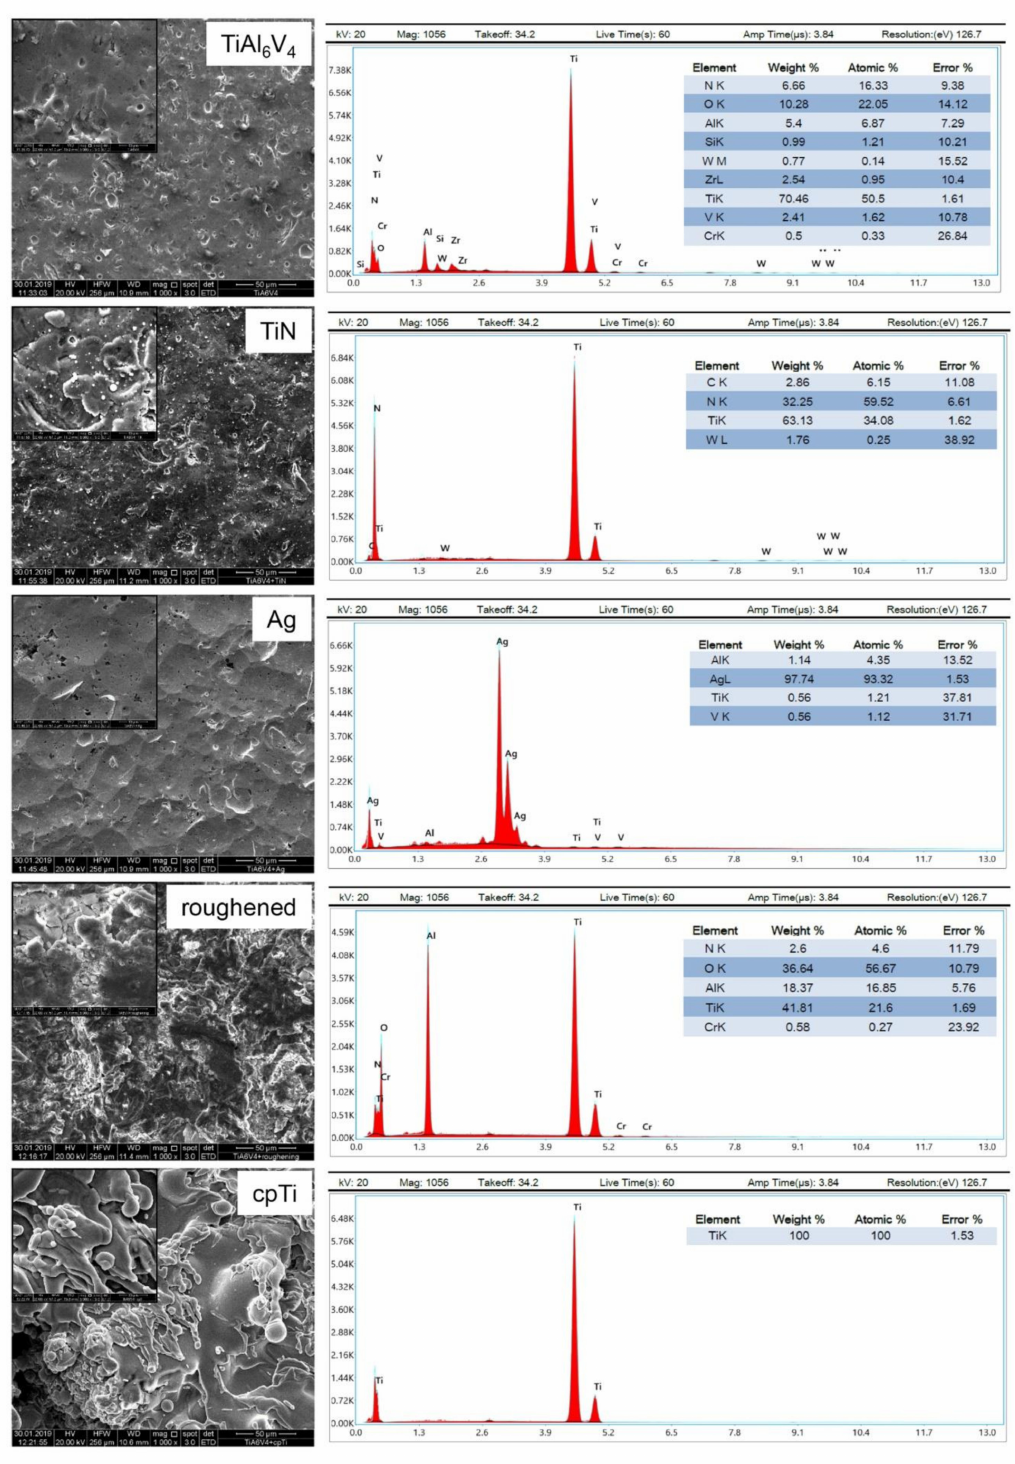
Figure 1. Surface characteristics. SEM (Scanning Electron Microscopy) energy dispersive X-ray spectroscopy (EDX) analysis of uncoated TiAl 6 V 4 , titanium nitride (TiN) coated, silver coated (Ag), a roughened surface, and a pure titanium coated surface (cpTi) (all 1000 × and 5000 × magnification). The corresponding EDX analysis exhibited changes of the surface quality between the uncoated TiAl 6 V 4 surface and the modifications regarding the composition of the chemical